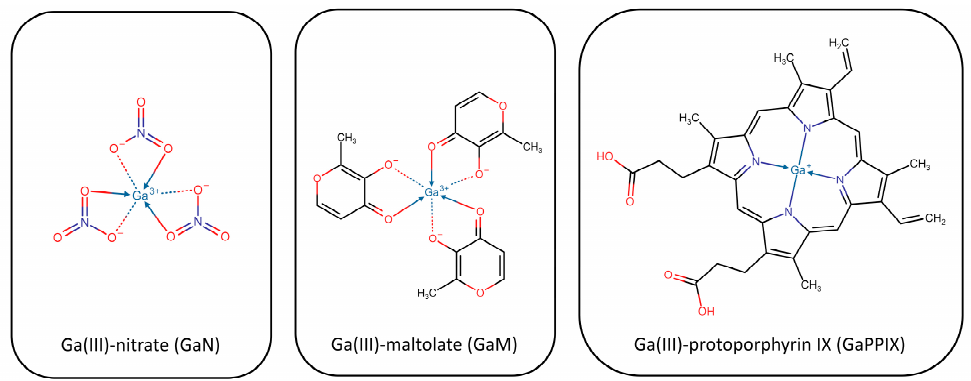
Figure 5. Representation of Ga-derivatives. The chemical structures were drawn with Chemicalize.